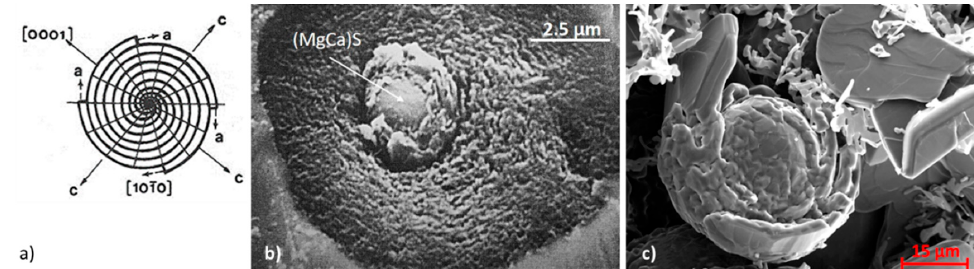
Figure 14. Curved-circumferential growth of graphite platelets: ( a ) Schematic representation [49]; ( b ) circumferential growth in cast iron around a (MgCa)S nucleus [50]; ( c ) circumferential growth in a Ni-C alloy, reproduced from [31] with permission from Elsevier.